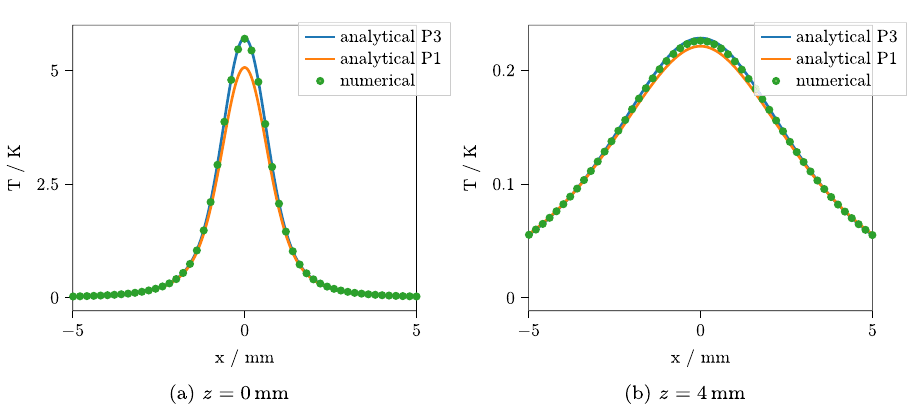
0 for two different 0 ◦ along the line y = =